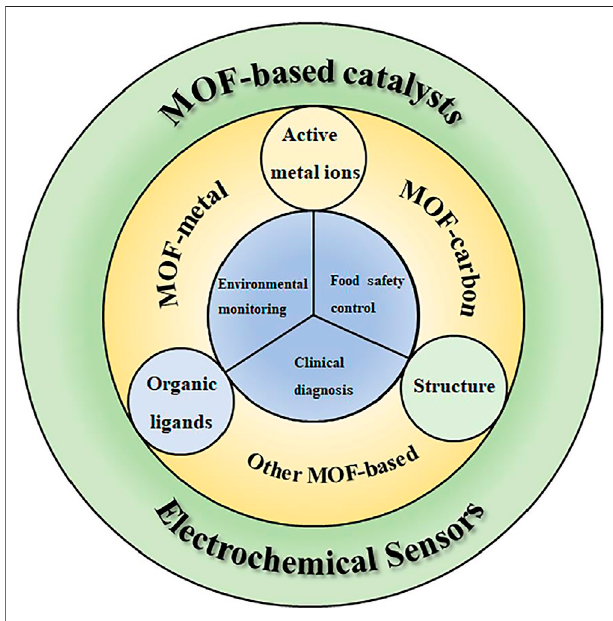
FIGURE 7 | Mechanism and application of MOF-based catalysts as electrochemical